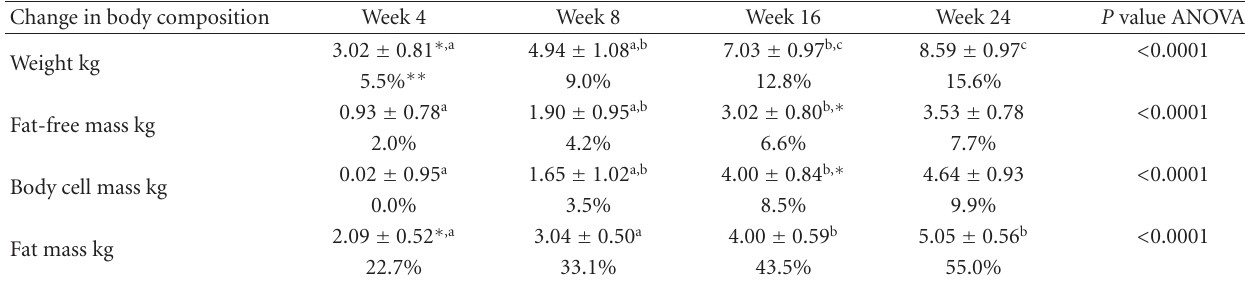
Table 2: Changes in body composition during treatment.